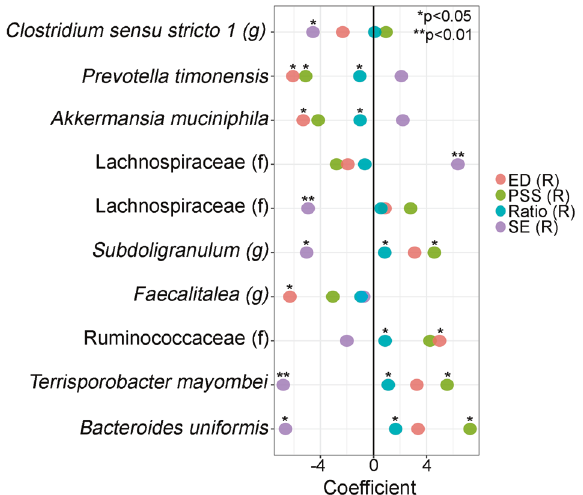
Fig. 2 Associations between ASV with rPS, rED, rSE and reduced Ratio scores. Associations between ASV normalized counts and each factor was determined using zero-in fl ated Generalized Linear Models that were adjusted by recruitment site and participant ’ s age. Models were adjusted for multiple comparisons. * q < 0.05; ** q <